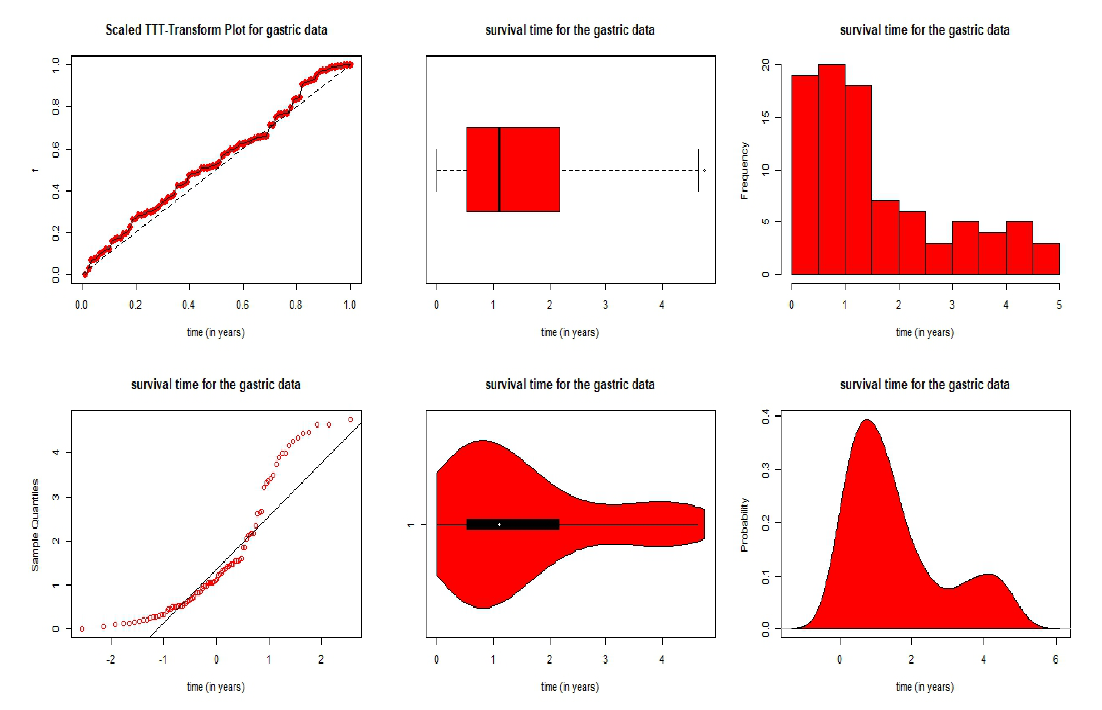
Figure 2. Fundamental plots for the survival time of the gastric cancer dataset.